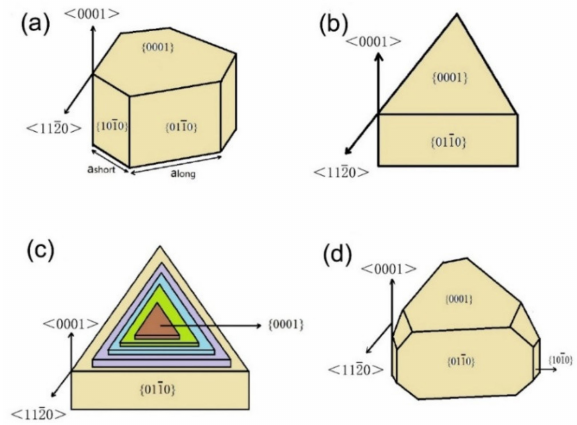
Figure 11. Schematic of ( a ) equilibrium shape of WC grain in Co binder and three–dimensional morphology of WC grains in ( b ) WC–10Co–0.8Cr 3 C 2 ; ( c ) WC–10Co–0.8VC; ( d ) WC–10Co–0.8TaC.